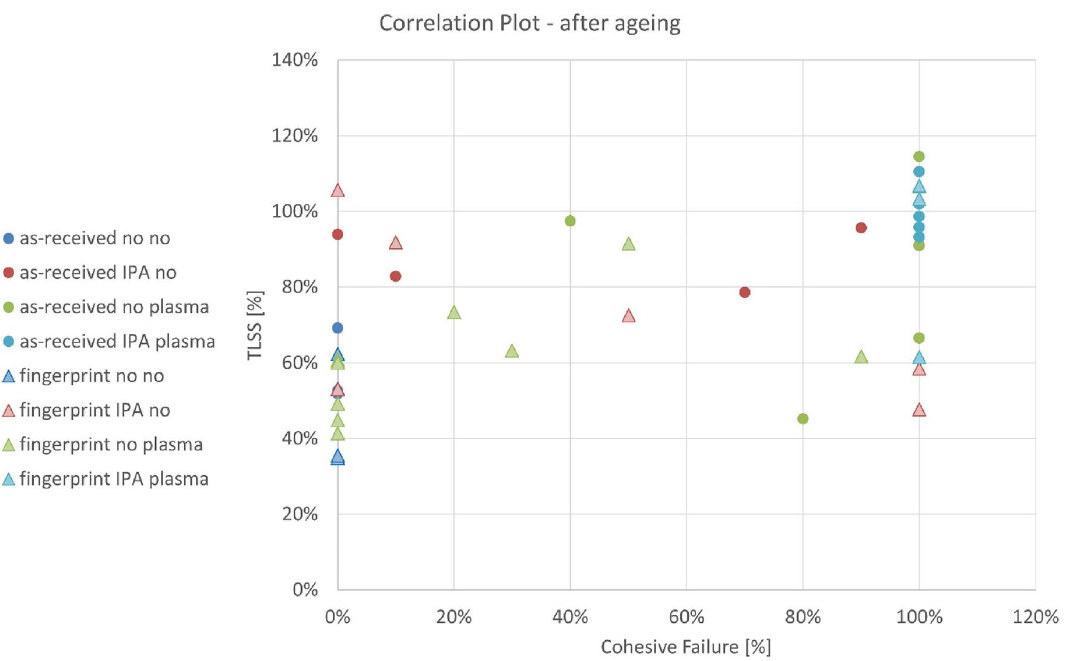
received or fingerprinted), optionally applying a cleaning step with isopropanol (IPA) and optionally performing surface pre-treatment with atmospheric pressure plasma (plasma) treatment are consid-